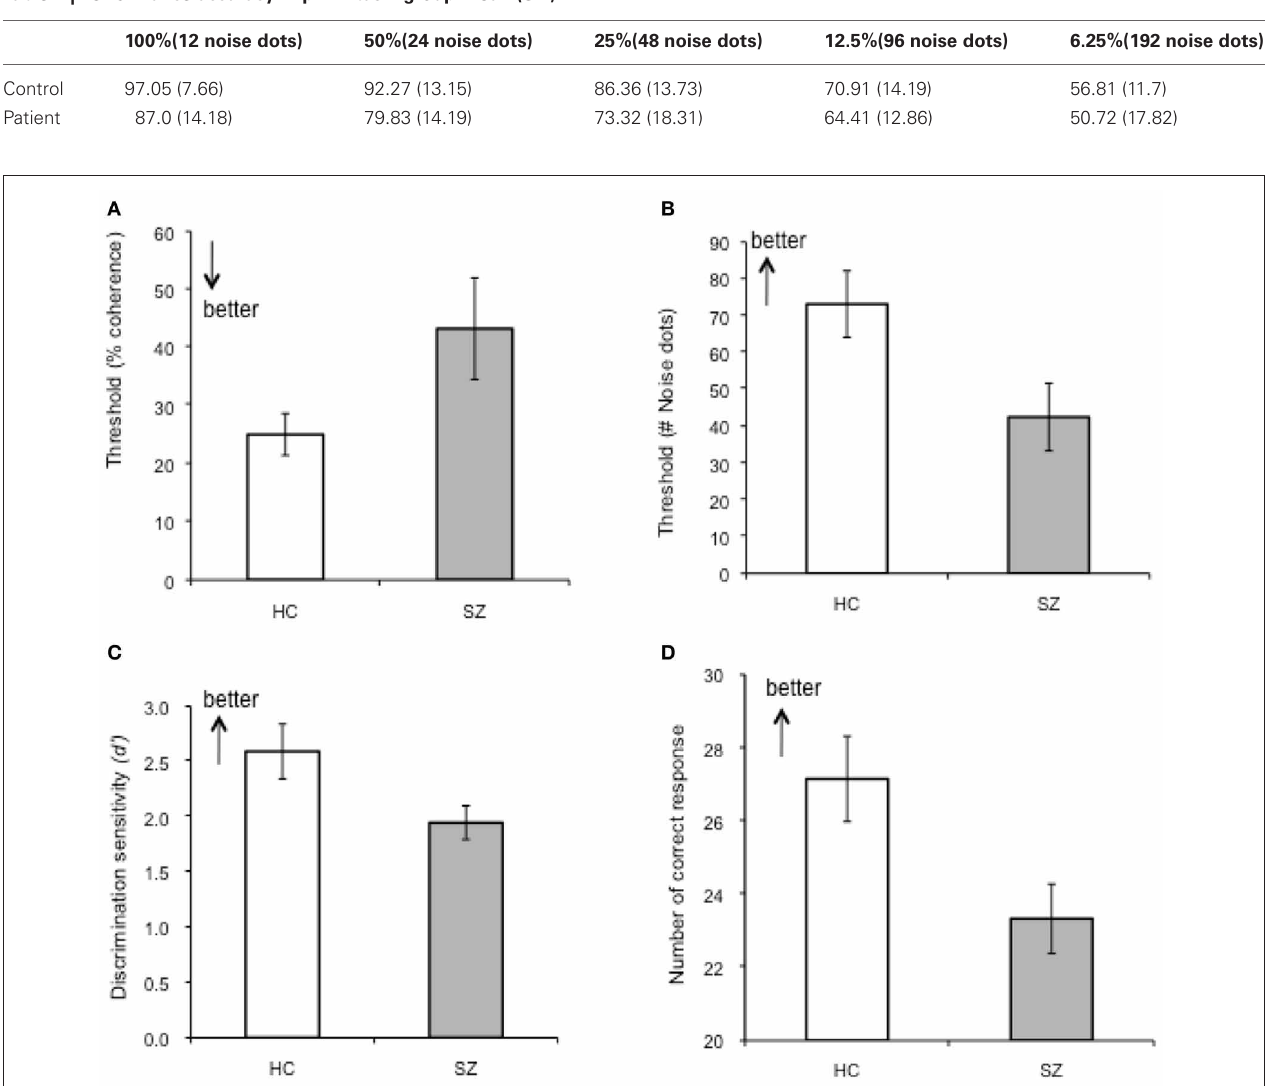
FIGURE 3 | Summary of the performances on basic visual motion perception and BM perception tasks. (A) Perceptual threshold for coherent motion detection (CM), (B) Perceptual discrimination threshold